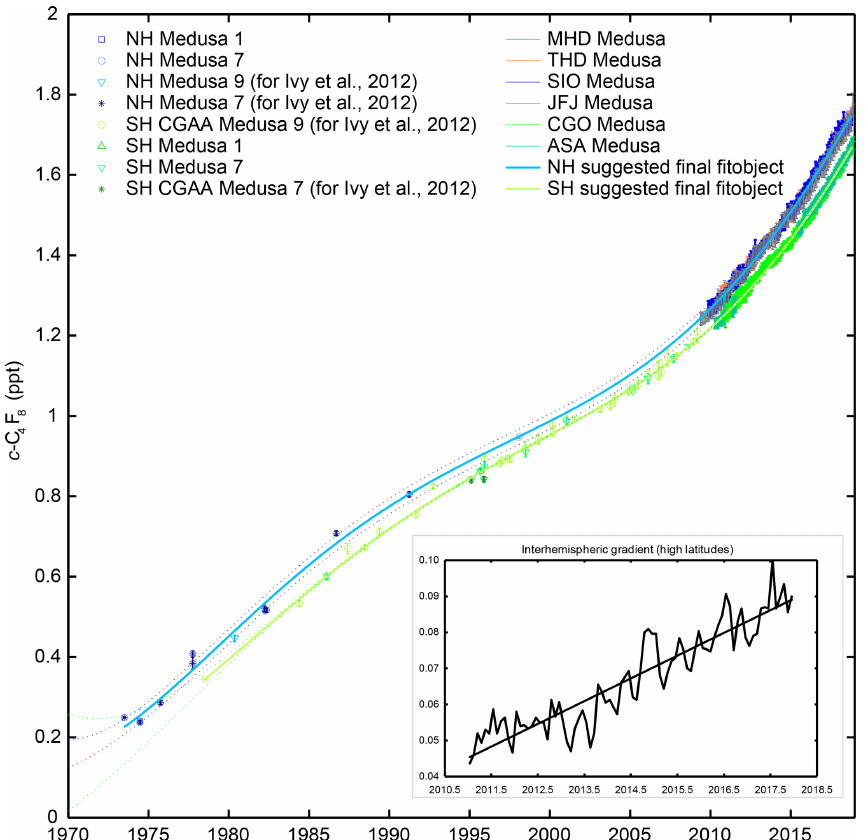
Figure 1. c -C 4 F 8 mole fractions reconstructed from the late 1970s to 2018 from archived air samples and in situ measurements in both hemispheres. Cape Grim Air Archive (CGAA) and archived NH air samples are shown with symbols in shades of green and blue, respectively, reflecting different data subsets. For recent years, in situ measurements are shown as pollution removed monthly means for extratropical stations in the NH (MHD in light blue, THD in orange, SIO in darker blue, JFJ in grey) and in the SH (CGO in lighter green, ASA in pale green). Shown are the final data after an iterative filtering process described in the main text. The final suggested fits are shown as bold light green (SH) and bold light blue (NH) polynomial fits. Confidence bands (2 σ ) are shown as dotted lines. Results for the tropical stations, RPB and SMO, the Asian stations, GSN and SDZ, and the Arctic station, ZEP, are omitted here for clarity. For individual samples, error bars reflect measurement precisions. For monthly means, error bars represent standard deviations. The inset shows the interhemispheric gradient from in situ measurements at high latitudes (MHD, THD, SIO, and CGO) from 2011 to